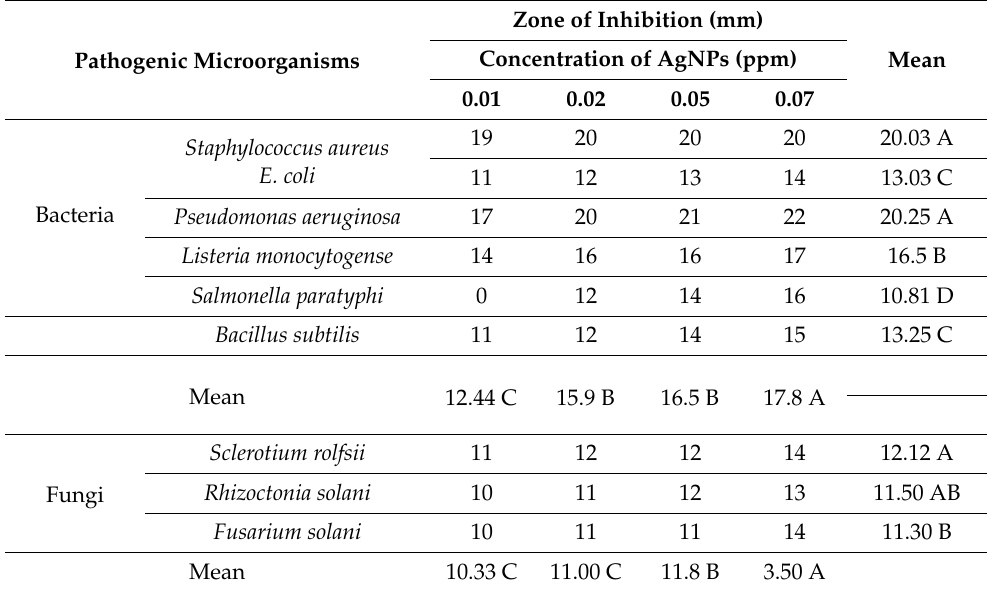
Table 1. Antimicrobial activity of different AgNPs concentrations produced by Streptomyces aizuneusis ATCC 14921 against some pathogenic microorganisms.